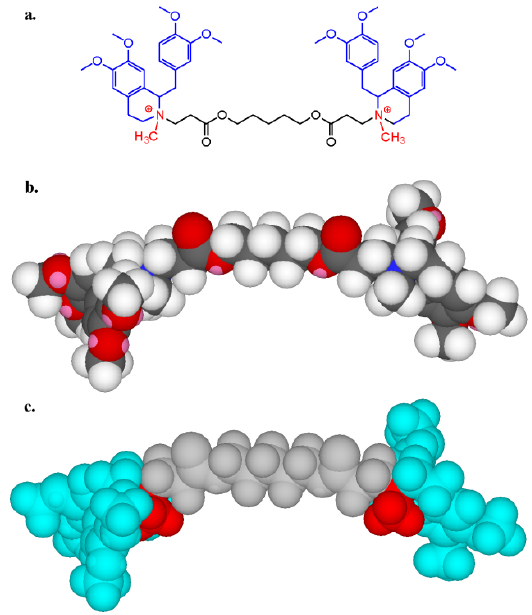
blocking drug (NMBD) atracurium which has two quaternary methylammonium groups (in red in a and c ), each forming part of a tetrahydroisoquinoline ring (blue in a and c ) and separated by a 13 atom chain (grey in a and c